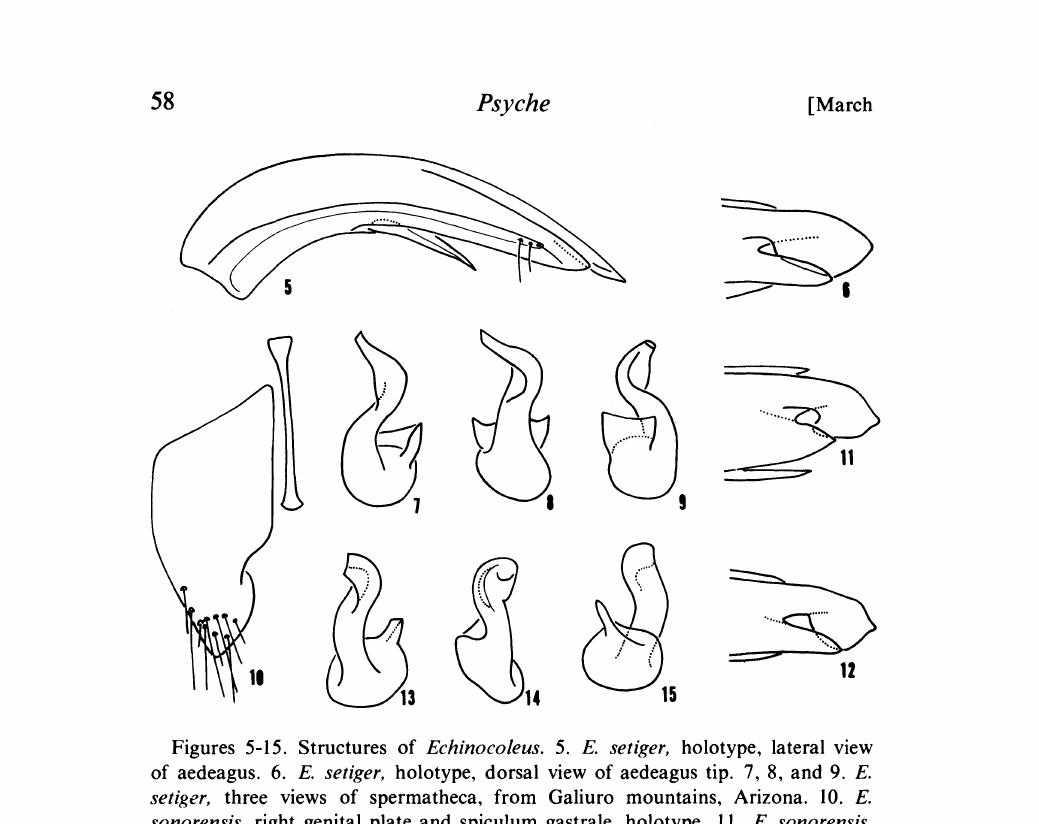
Figures 5-15. Structures of Echinocoleus. 5. E. setiger, holotype, lateral view of aedeagus. 6. E. setiger, holotype, dorsal view of aedeagus tip. 7, 8, and 9. E. setig, er, three views of spermatheca, from Galiuro mountains, Arizona. I0. E. sonorensis, right genital plate and spiculum gastrale, holotype. 11. E. sonorensis, holotype, dorsal view of aedeagus tip. 12. E. chihuahuensis, allotype, dorsal view of aedeagus tip. 13, 14, and 15. E. chihuahuensis, holotype, three views of